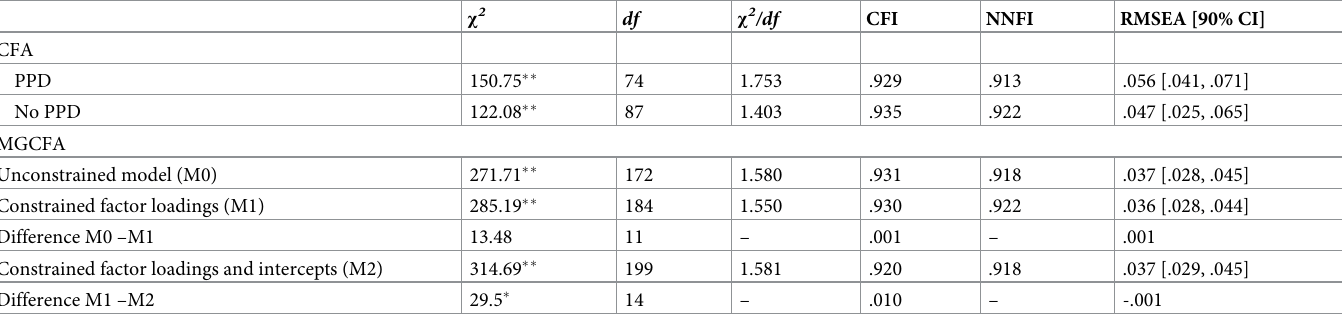
Table 2. Fit of the Confirmatory Factor Analysis (CFA) of the 15-item version of the Parental Reflective Functioning Questionnaire, Infant Version (PRFQ-I) with the total sample (n = 423), and measurement invariance (MGCFA) across groups (n = 237 mothers with PPD and n = 186 mothers without PPD). χ 2 df χ 2 /df